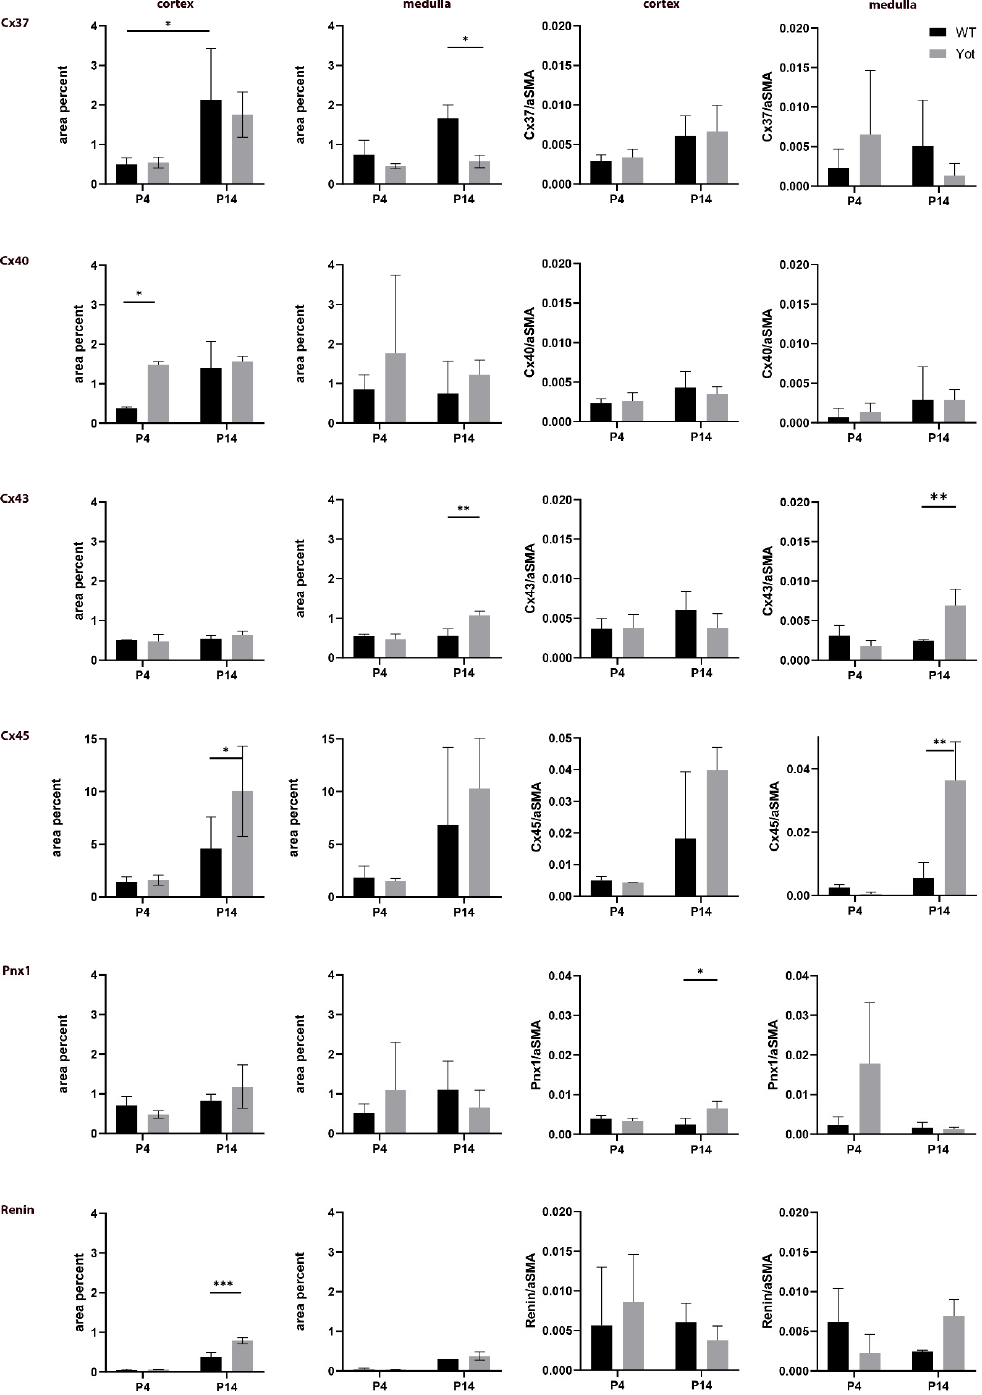
Figure 2. The area percentages of Cx37, Cx40, Cx43, Cx45, Panx1 and renin in the cortex and medulla of wild type and yotari mouse kidneys and their co-localization with α -Smooth muscle actin (aSMA). Data is presented as the mean ± SEM (vertical line). Significant differences were indicated by * p < 0.05, ** p < 0.001, *** p < 0.0001 (Two-way ANOVA followed by LSD multiple comparison test).